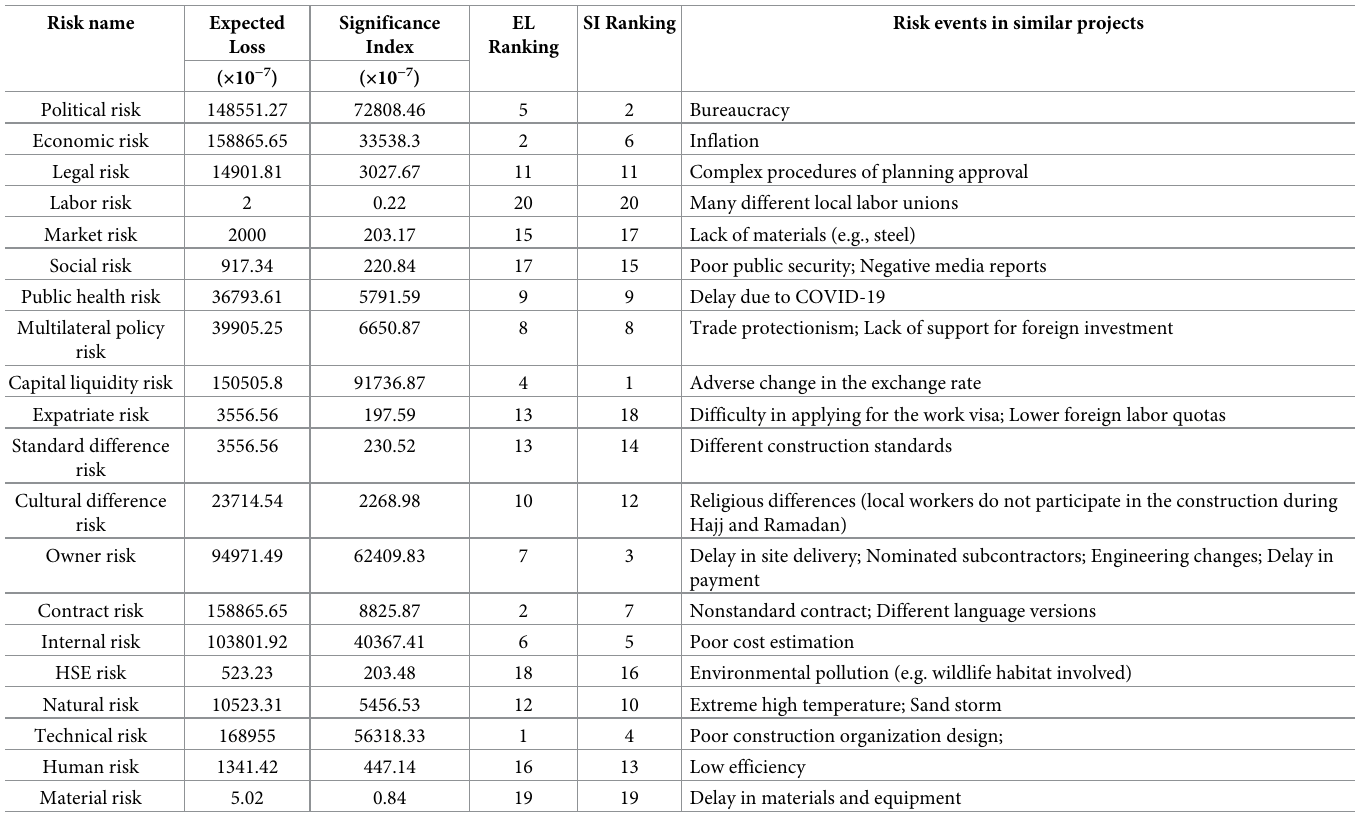
Table 7. Results for the expected loss, significance index, and corresponding